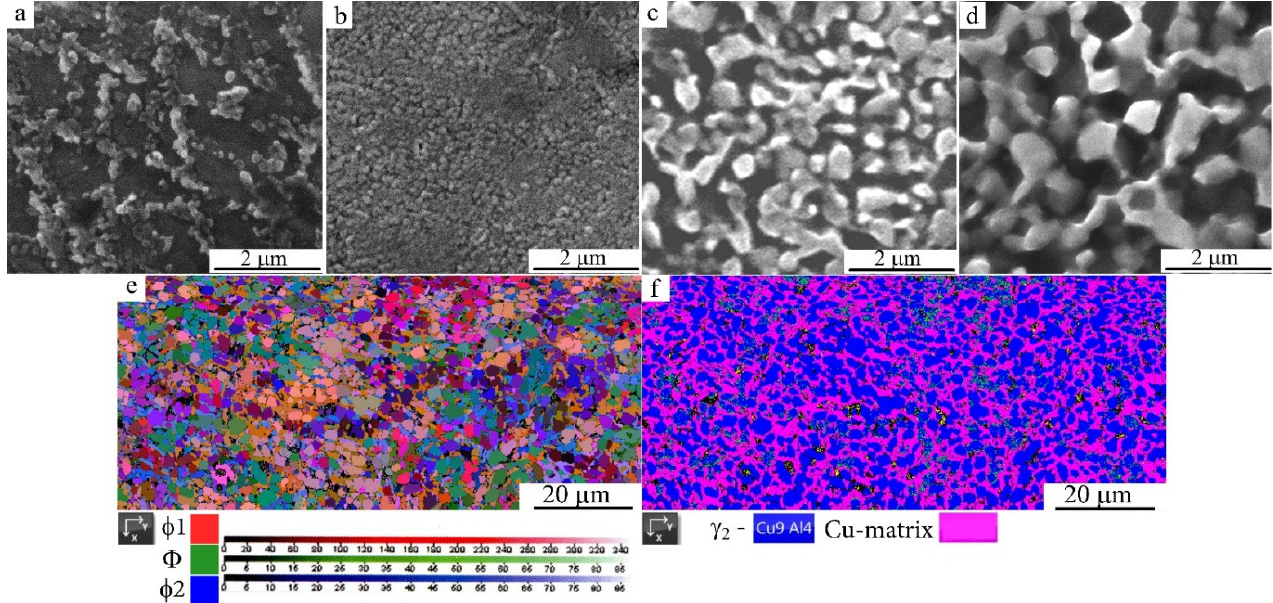
Figure 29. ( a – d ) SEM images in SE mode of the microstructure, ( e ) map of the disorientation of the structure in Euler angles and ( f ) phase map of image quality in EBSD mode of the Cu-14Al-3Ni alloy after the HPT of 10 revolutions and annealing at temperatures of ( a ) 373 K, 30 min, ( b ) 673 K, 30 min, ( c ) 773 K, 30 min, ( d ) 873 K, 30 min, ( e , f ) 873 K, 60 min